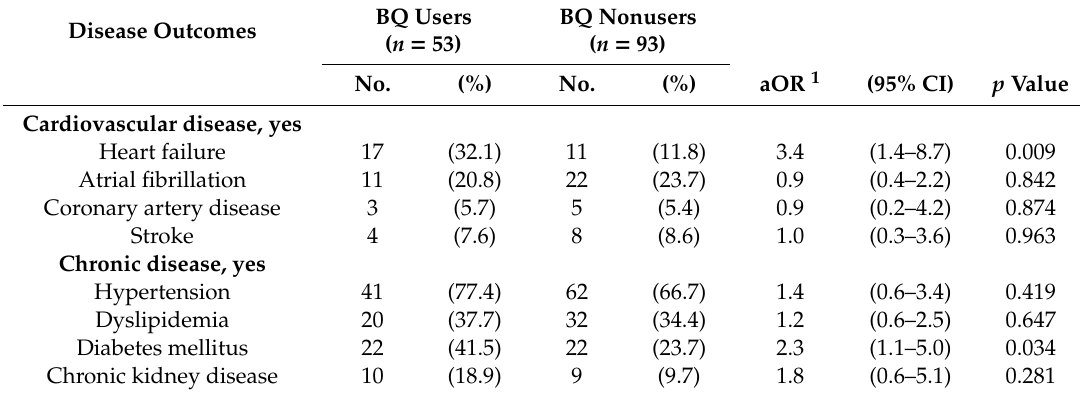
Table 3. Adjusted odds ratio (aOR) of cardiovascular and chronic disease associated with betel-quid (BQ) use among Holter monitor